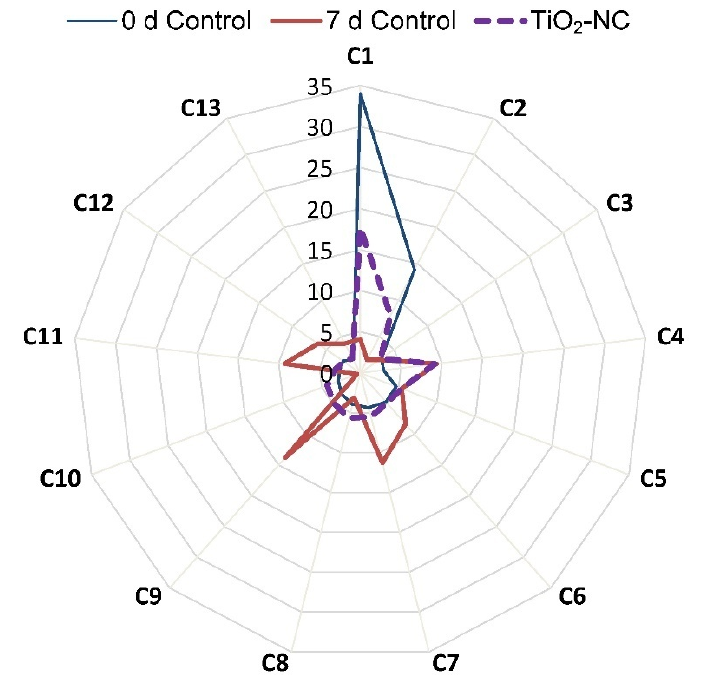
Figure 10. Radar plot showing the pattern of changes in concentration of major constituents of essential oil under TiO 2 -NC treatments with respect to control at 0 d and 7 d storage of postharvest at 25 °C.